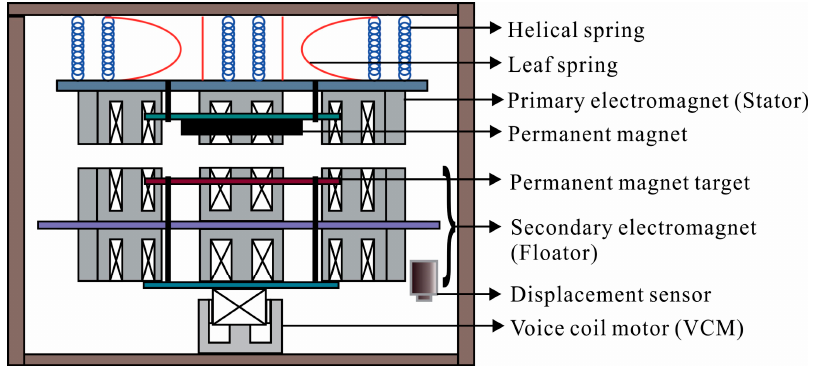
Figure 7. Schematic diagram of the experimental apparatus for investigating self-stabilization during the suspension.